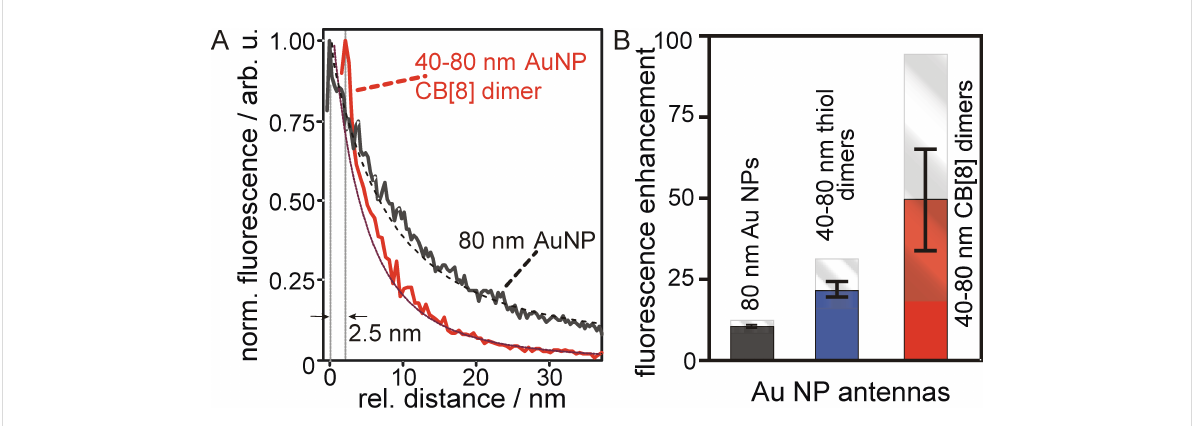
Figure 3: Antenna enhanced fluorescence of high QY emitters. (A) Normalized fluorescence emission rates as a function of the antenna-molecule distance for a CB[8]-mediated 40–80 nm AuNP dimer and a spherical 80 nm AuNP monomer antenna. The red, dotted and the black, dashed line cor- respond to the evaluation of the calculated electromagnetic field for these antennas. (B) Comparison of the absolute and averaged enhancement factors obtained for multiple 80 nm monomer antennas, thiol- and CB[8]-mediated 40–80 nm AuNP dimers.The error bars display the standard devia-